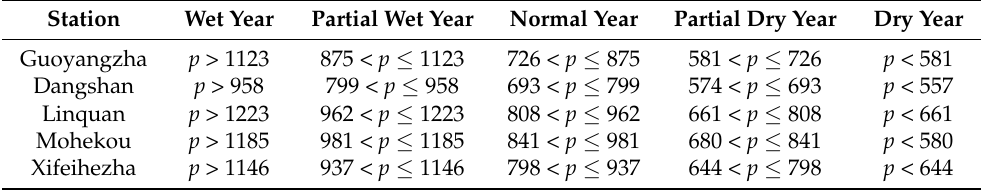
Table 5. Statistical dividing standard of types of hydrological year based on annual precipitation in northern Anhui province. Station Wet Year Partial Wet Year Normal Year Partial Dry Year Dry Year Guoyangzha p > 1123 875 < p ≤ 1123 581 < p ≤ 726 p < 581 Dangshan p > 958 799 < p ≤